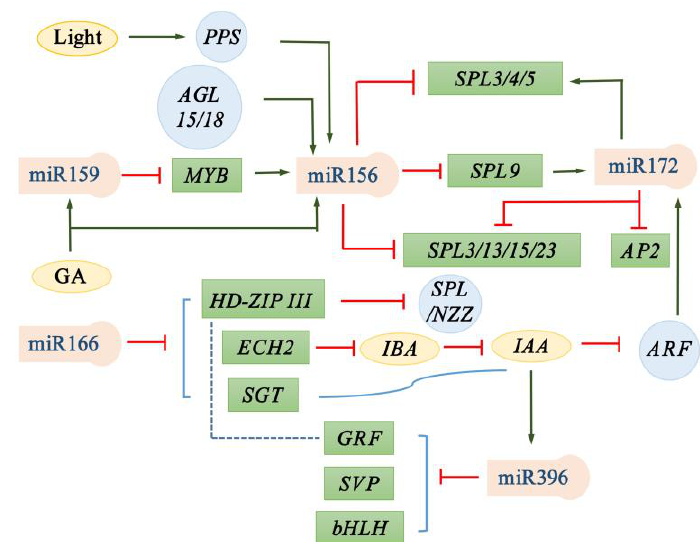
Figure 3. Genetic networks of developmental phase transitions regulated by miRNA-target modules together with their upstream or downstream transcription factors, hormone and light. Arrow represents activation, line with a bar represents repression and dotted line represents possible interactions. MiRNAs are shown in pink boxes and their targets are shown in green ones. Hormones and light are shown in yellow oval frames, and transcription factors are shown in blue round frames.